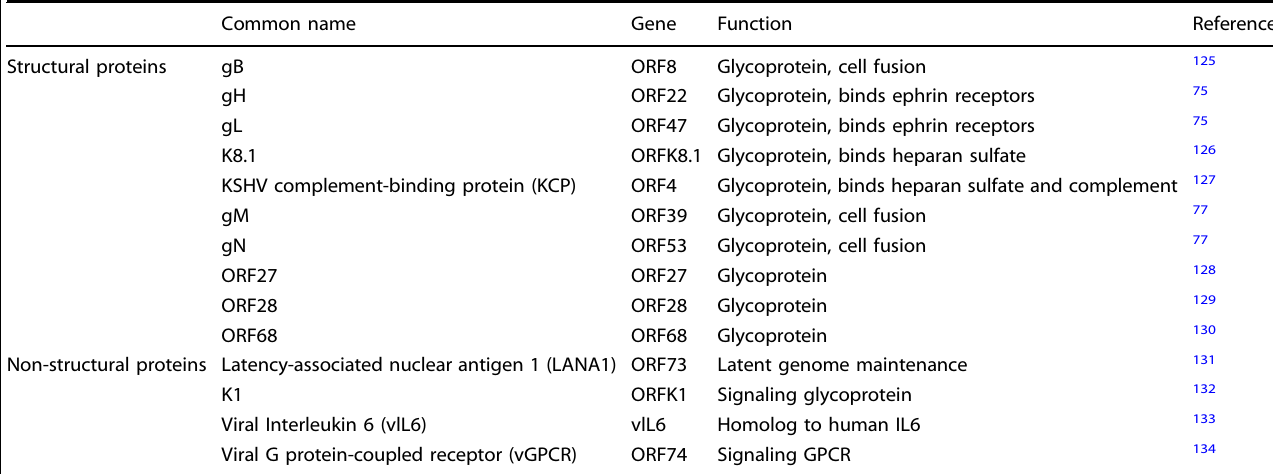
Table 1. KSHV antigens that might become the basis for effective KSHV